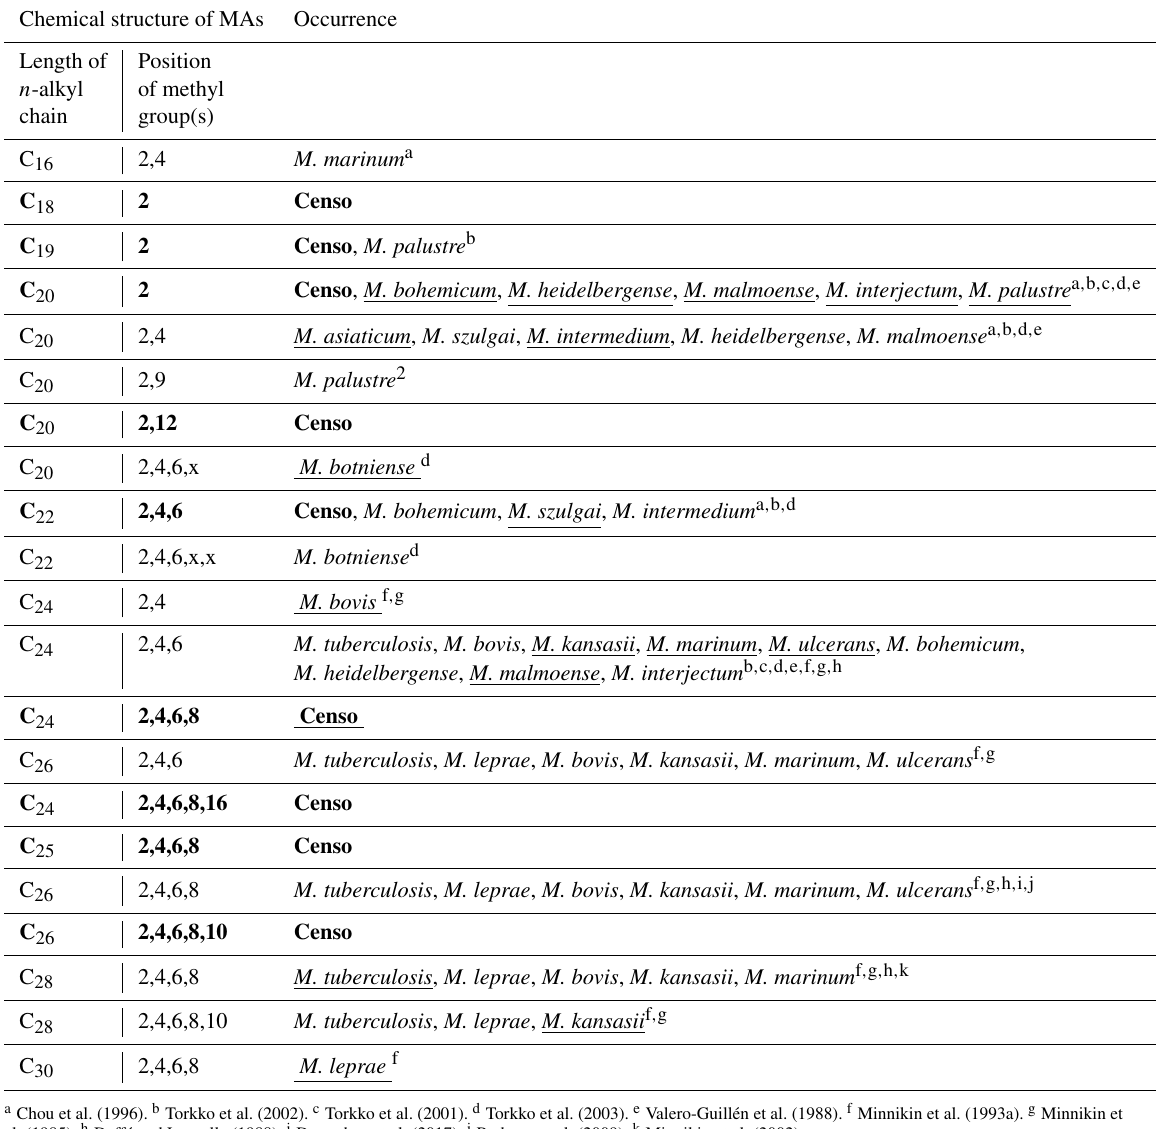
Table 2. Chemical variability and occurrence of MAs in the Censo seep soils and in the most relevant mycobacterial species. The underlined names of the mycobacterial species indicate the major MA configuration in the mycobacterial species. The x in the position of methylations in the n -alkyl chain features an unidentified position of the methyl group. MAs indicated in bold typeface are MAs identified in the Censo seep